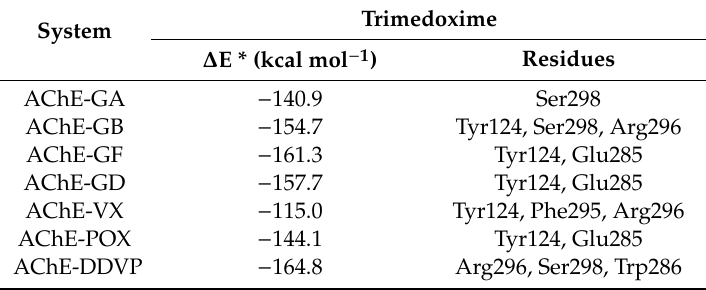
Table 2. Docking results for trimedoxime inside di ff erent AChE–organophosphorus compound (OP) adducts. System